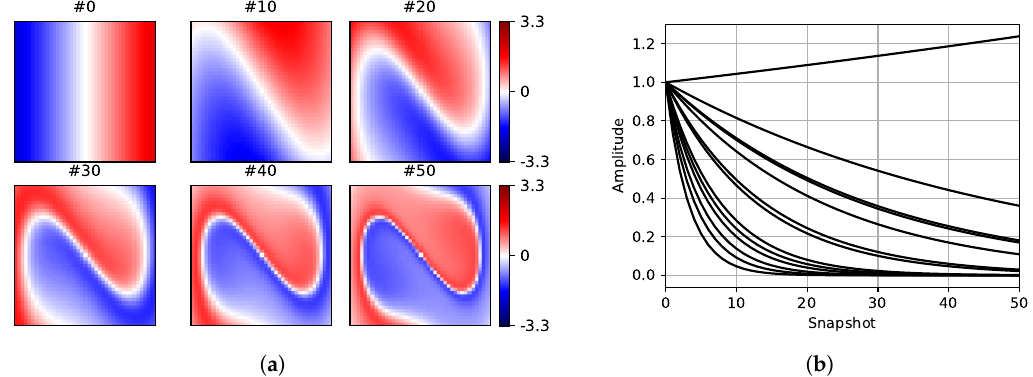
Figure 4. The reference Duffing dataset. ( a ) Six sample snapshots are shown. All 51 snapshots were used in calculations. ( b ) The amplitudes of the dynamic mode shapes are shown. Since the complex eigenvalues come in pairs of conjugate numbers, only those with non-negative imaginary parts are